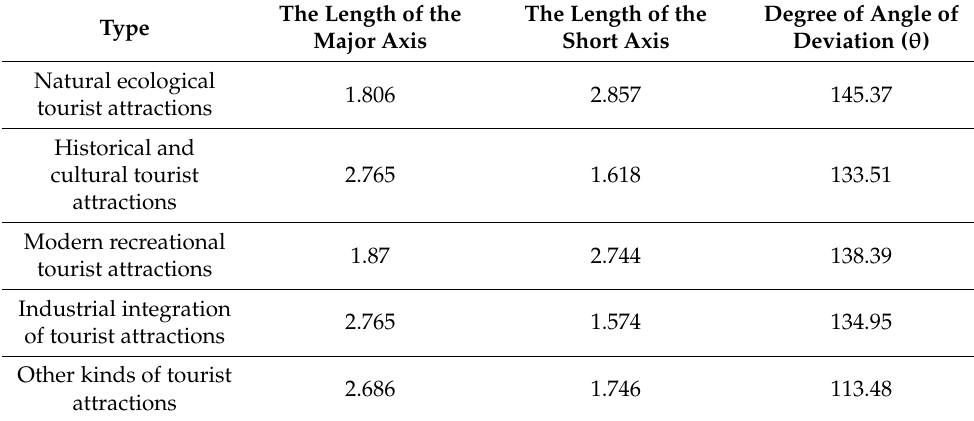
Table 4. Standard deviation ellipse parameters of the five types of tourist